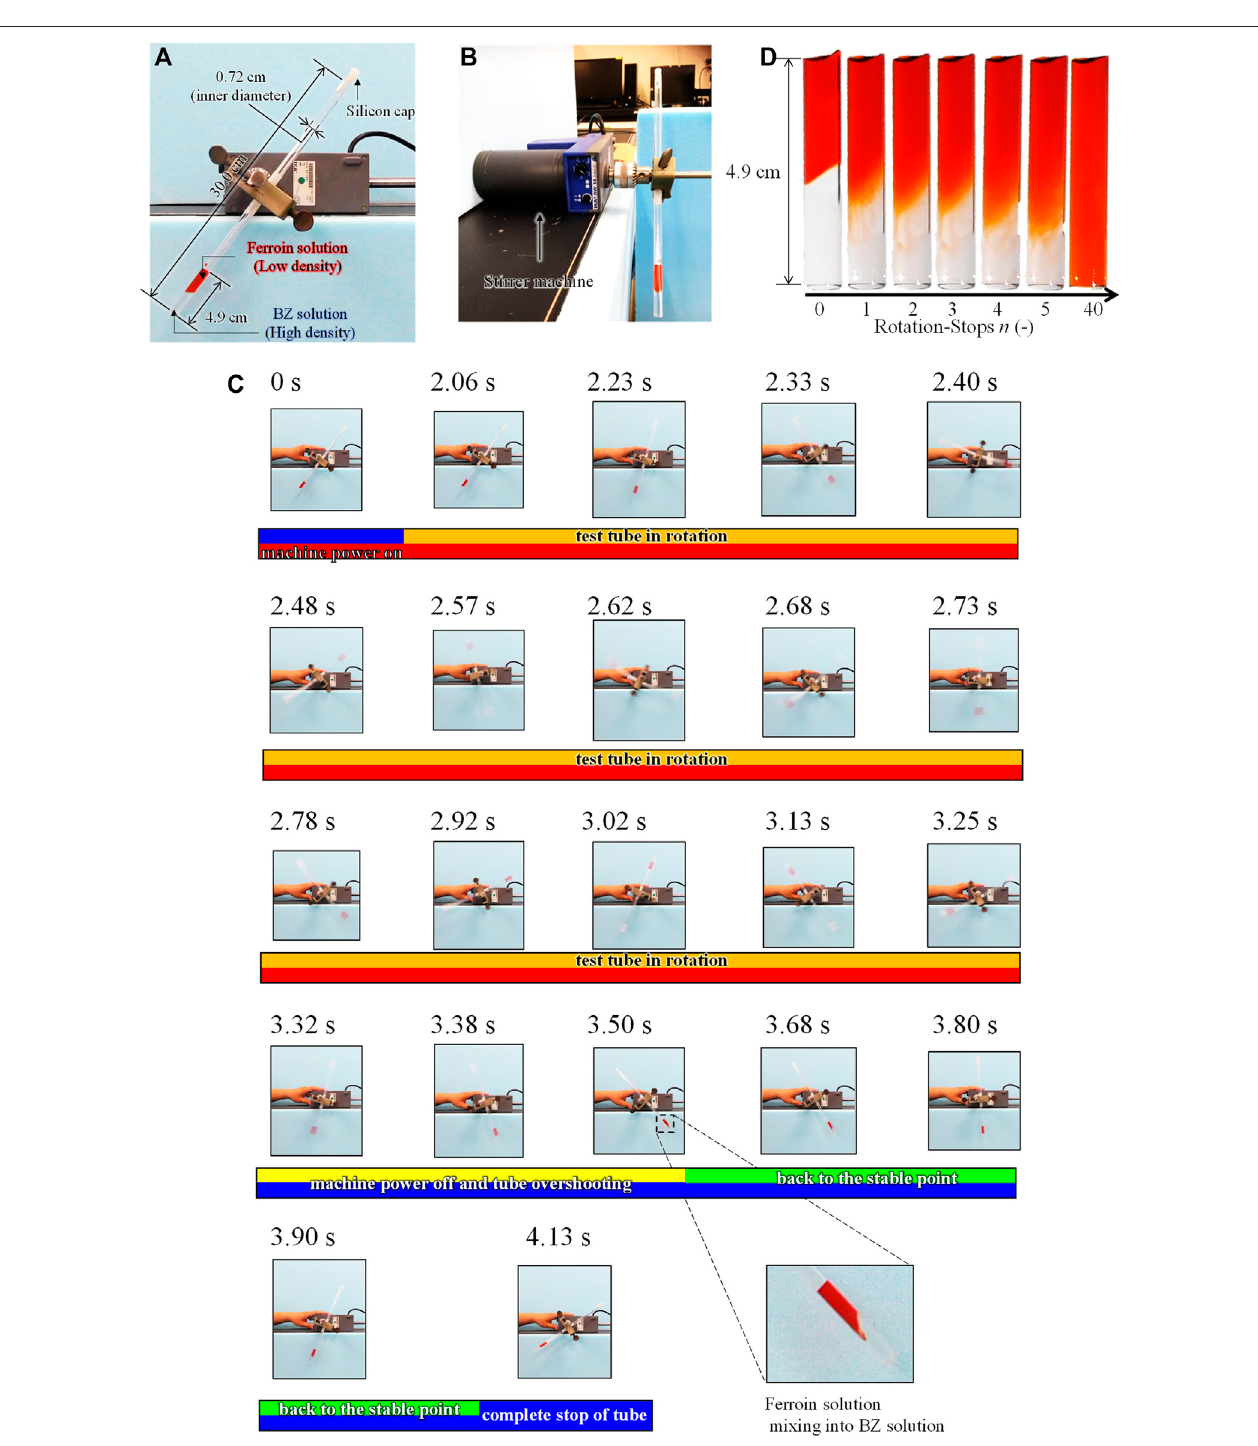
FIGURE 1 | Rotation-and-stop method; (A) Front view and (B) side view of the experimental setup. (C) The behavior of the solutions in a tube during a single rotation-stopcycle. (D) Themixingprocess ofbetween Na 2 SO 4 and ferroin solutionsin atest tube byrotation-and-stop method. The residual imagein the (C) iscaused by the fast rotation (~90 cm/s) and the slow frame rate (30 frame/s).